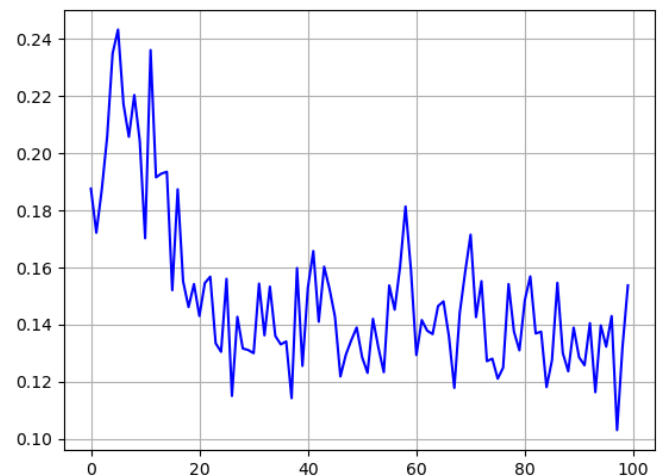
Figure A4. EURUSD Losses , 45